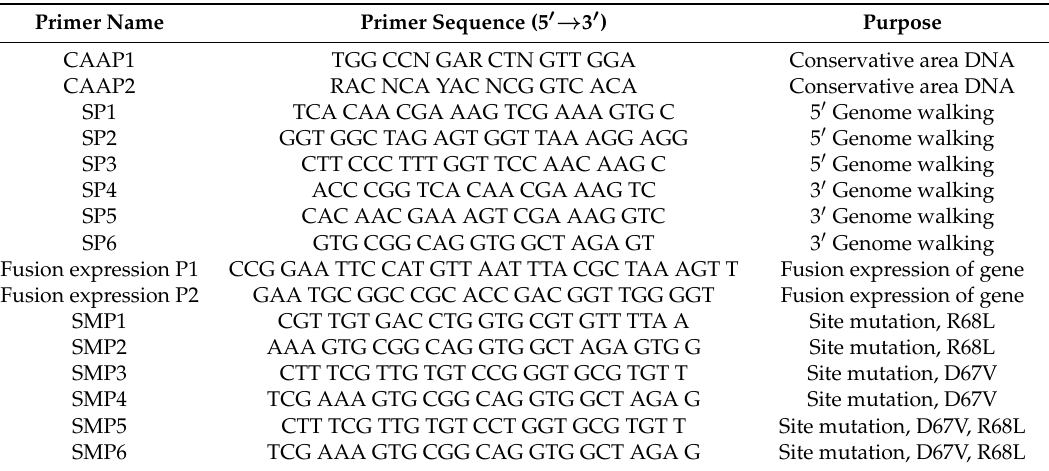
Table 1. Primers used in this